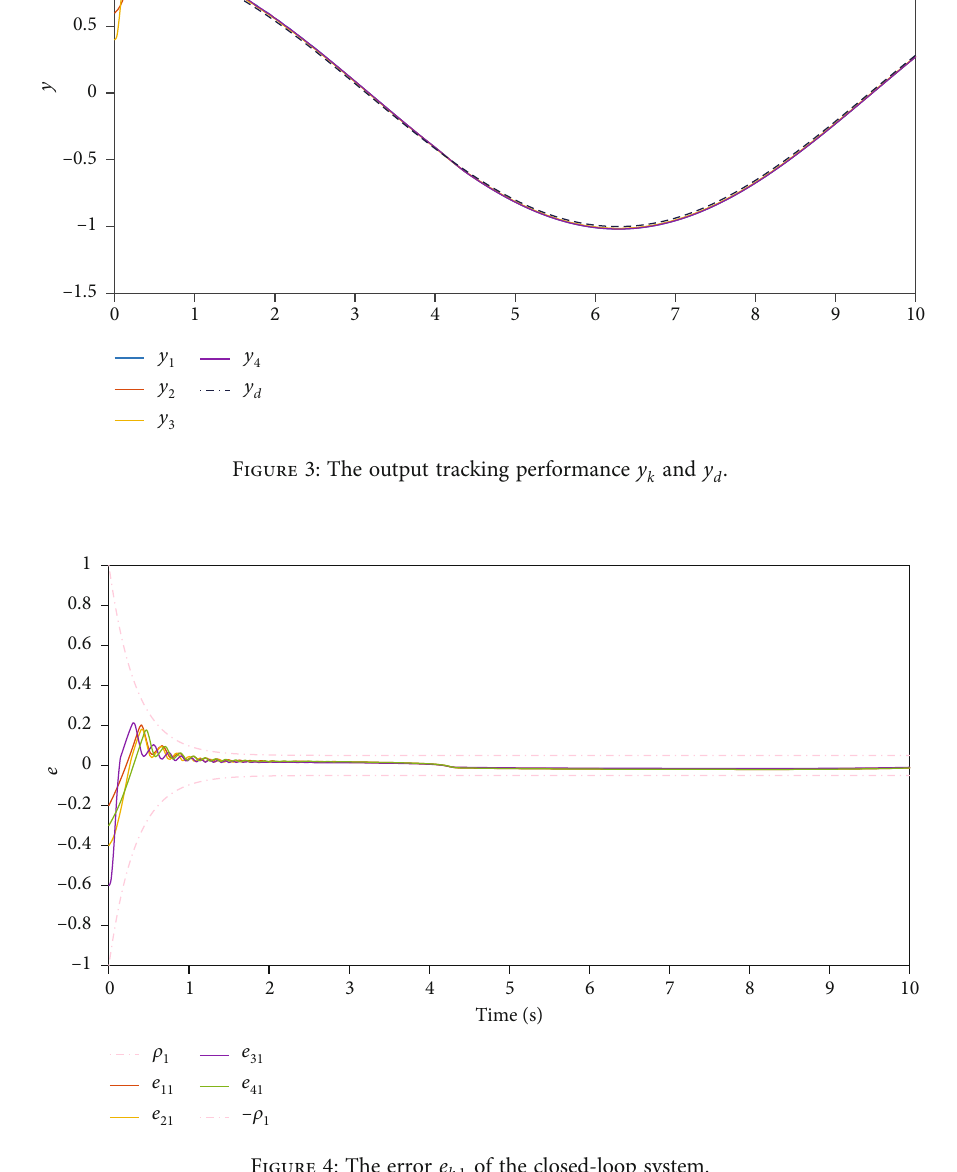
of the closed-loop k ,1